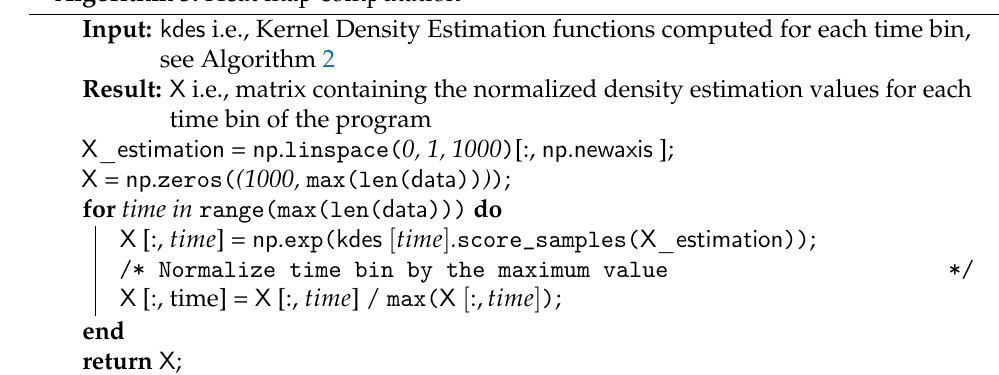
Algorithm 3: Heat map computation